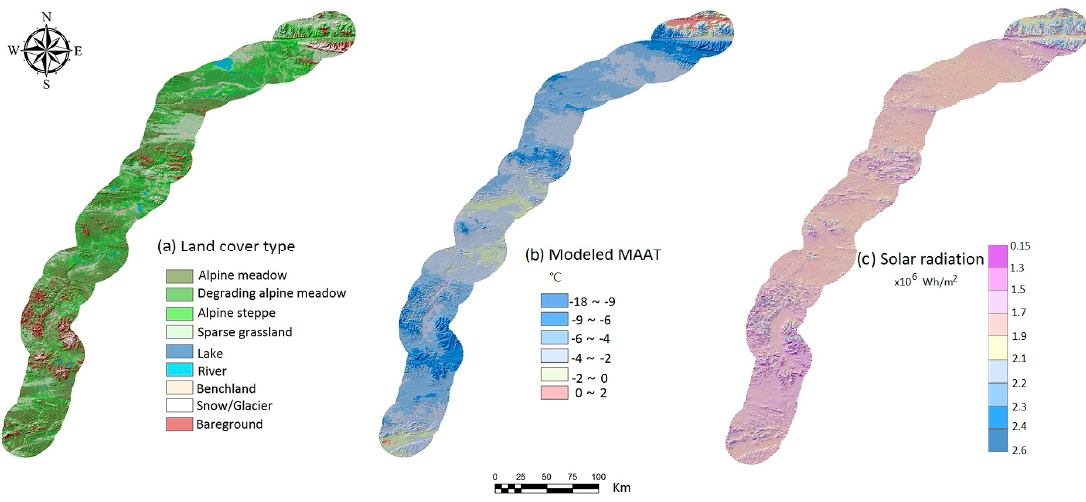
Figure 2. Remote sensing-independent variable products. ( a ) Land cover type map of the study area-QTEC, derived from GF-1 multispectral data using object-oriented classification approach. ( b ) Modeled mean annual air temperature distribution in the QTEC. ( c ) Spatially distributed solar radiation.